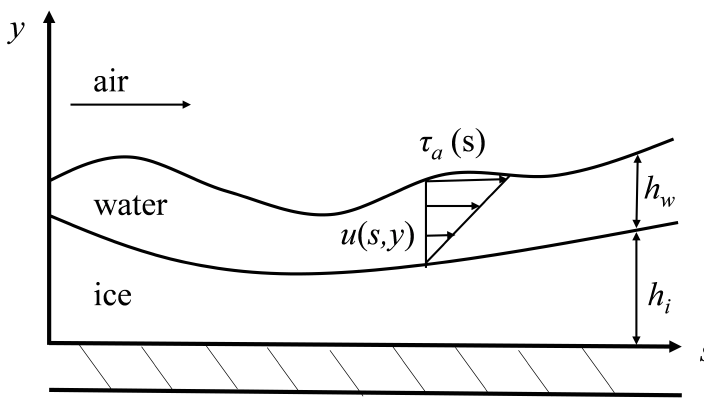
Figure 3. Diagram of water film and